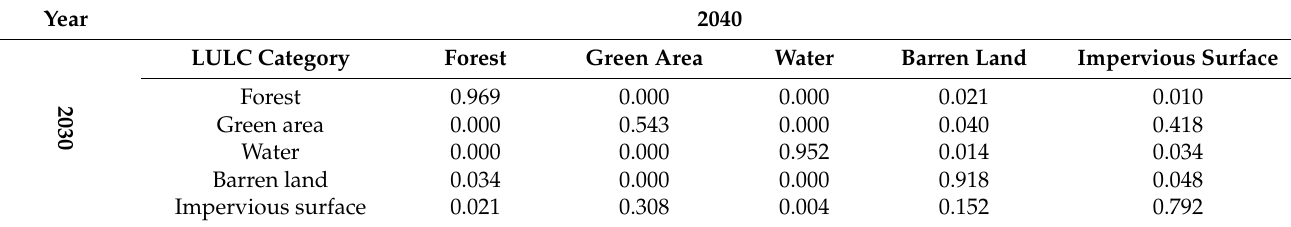
Table 11. Transition matrix from 2030–2040.